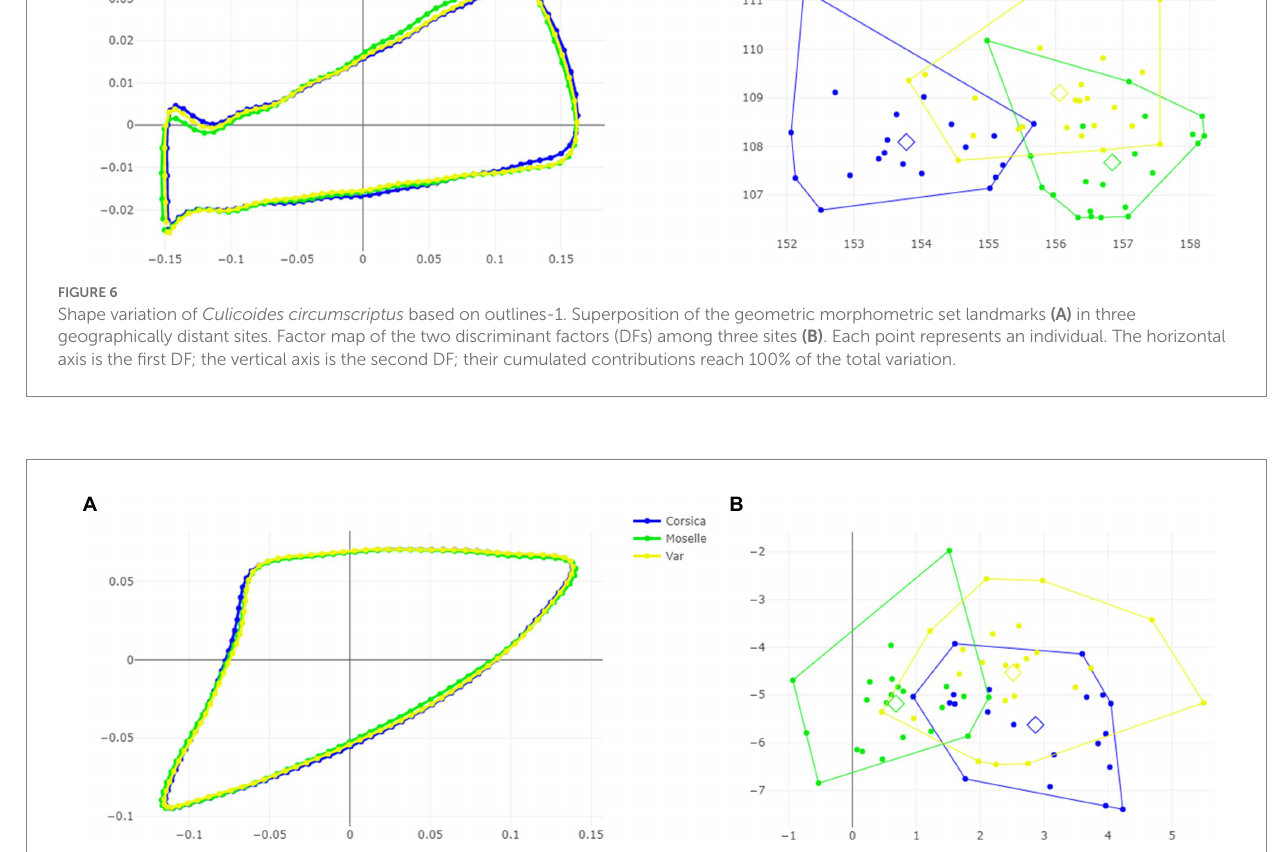
FIGURE 7 Shape variation of Culicoides circumscriptus based on outlines-2. Superposition of the geometric morphometric set landmarks (A) in three geographically distant sites. Factor map of the two discriminant factors (DFs) among three sites (B) . Each point represents an individual. The horizontal axis is the first DF; the vertical axis is the second DF; their cumulated contributions reach 100% of the total variation.